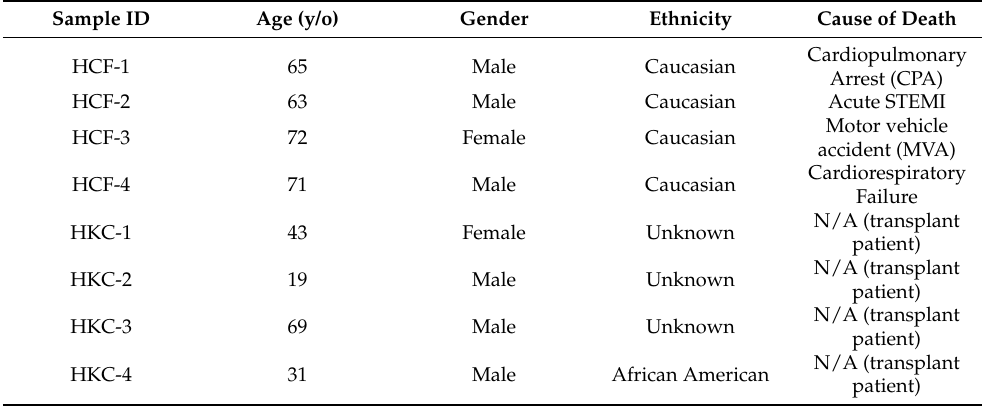
Table 10. Clinical phenotypes of primary human corneal stromal fibroblast cells derived from unaffected and KC